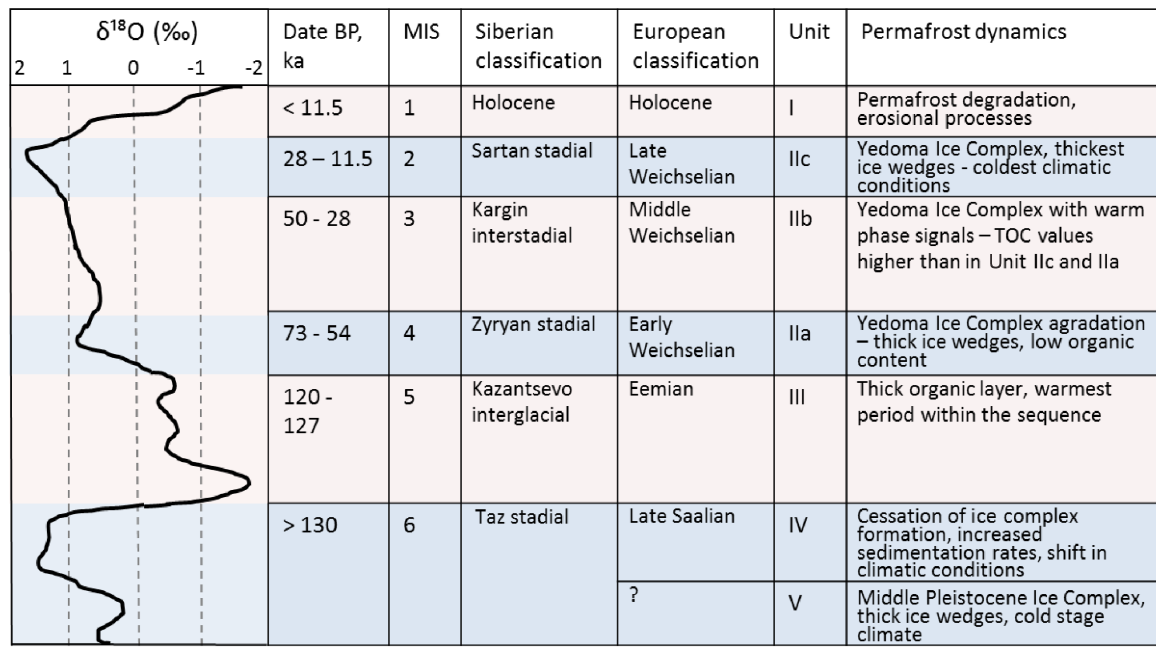
Table 4. Overview of permafrost dynamics recorded in the Batagay sequence in presumable correlation with global and regional climate histories. Due to the sparse dating resolution, the correlation is mainly based on the chronostratigraphic comparison of Batagay and lowland exposures. Global climate history is represented by marine isotope stages (MISs; Aitken and Stokes, 1997) derived from the δ 18 O curve (modified from Pisias et al., 1984), reflecting global temperature changes studied in deep sea cores. Negative δ 18 O ‰ values reflect warm climate stages, while positive values identify cold phases. The regional Siberian climate phases are given according to Sachs (1953). The European regional climate events for comparison are named according to Litt et al.